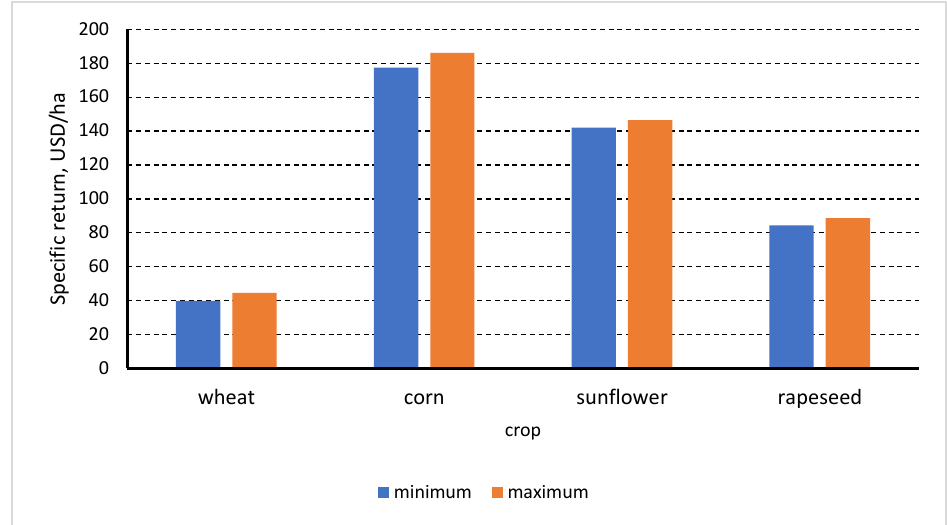
cific return. The increase in the area leads to a decrease in the payback period of invest- Figure 7. An increase in crop production income from the use of low-cost irrigation systems. Figure 7. An increase in crop production income from the use of low-cost irrigation systems. ment costs. Results for wheat confirm the above idea.